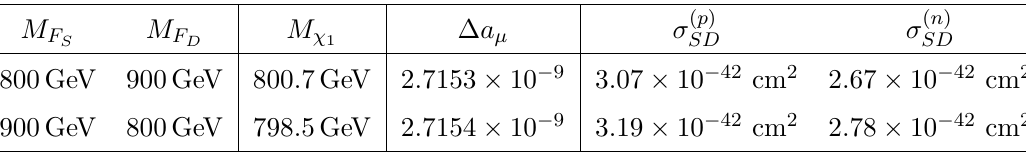
Table 3. Comparison of the singlet-like and doublet-like DM model points. The other parameters are M ˜ =1000 GeV, y 1 H = − 0 . 2 , y 2 H = 0 . 3 , y 1 = y 2 = λ L = λ 0 L